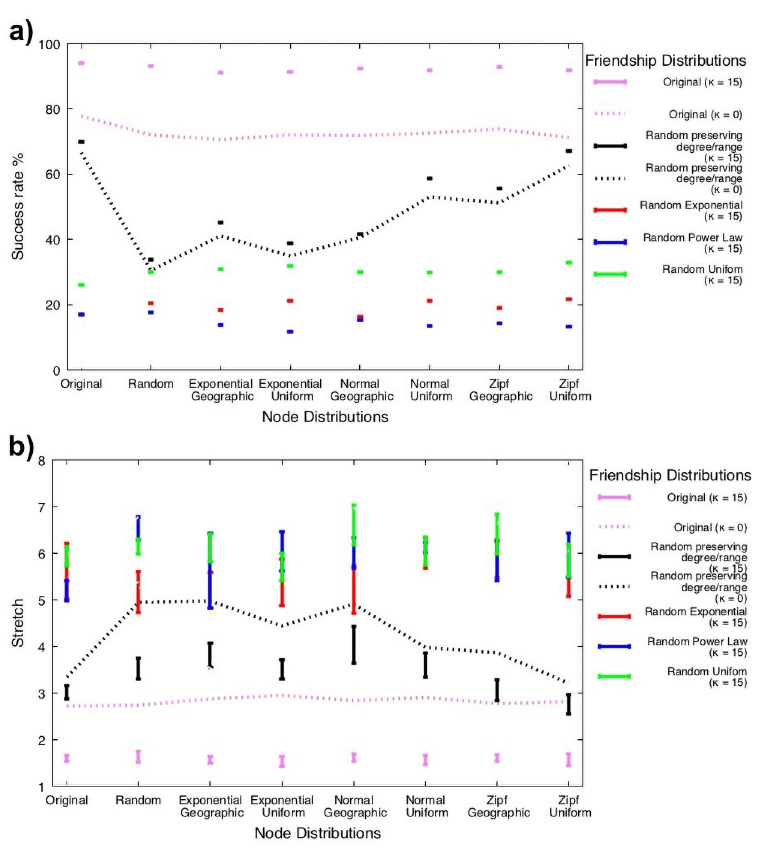
Fig 2. (a-b) show plots with error bars of success rates (a) and stretches (b) achieved with partial knowledge of i- friends under the different distributions of friendship edges as a function of various distributions of nodes into space. Plots represent the results of running 10 samples of each distribution resulting in 100 samples for each case of the considered friendship edge distributions. Each of these samples was executed 10 times and averaged results plotted. Each friendship edge distribution has a unique color assigned to its plots and two best performing distributions have also plots of their stretches achieved without knowledge of i-friends marked with the dashed line. We describe all distributions of friendship to edges and nodes into space in the text. Plots for runs with awareness of i-friends were computed using kappa limit of the number of i-friends set to 15, which, if needed, are uniformly randomly chosen from i-friends for each friend of the sender. The error bars were in the range of [0.002, 0.039] for success rates (a) and in the range of [0.07, 1.61] for stretches (b).